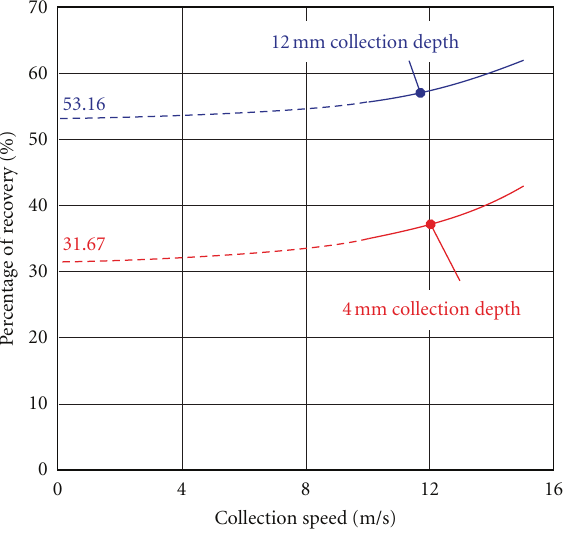
Figure 6: The dependence of percentage of recovery on collection